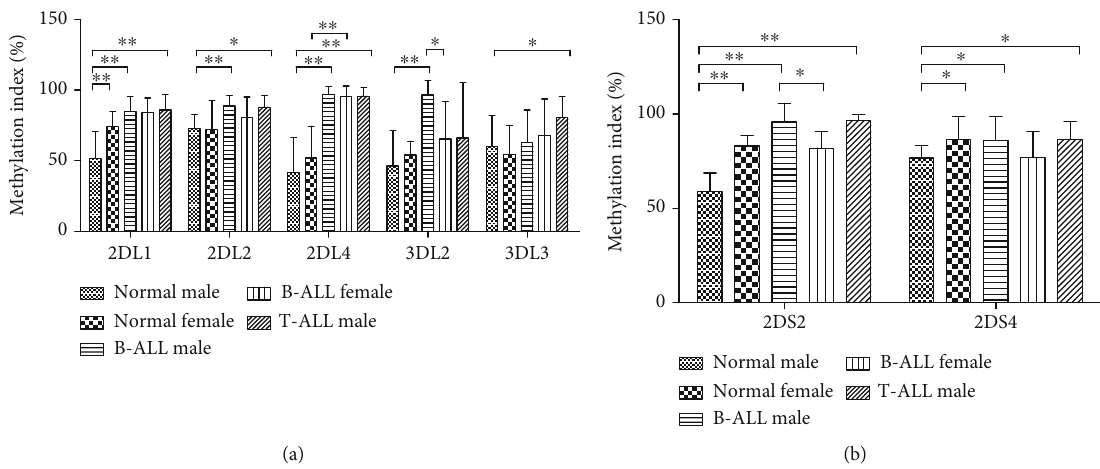
Figure 2: Methylation indexes in the promoter regions of (a) inhibitory KIR genes and (b) activating KIR genes in normal male controls ( n = 12 ), normal female controls ( n = 12 ), B-ALL male patients ( n = 12 ), B-ALL female patients ( n = 12 ), and T-ALL male patients ( n = 10 ). Data are presented as mean ± standard deviation . Mann-Whitney U test compared mean of two groups. “ ∗ ” indicates statistical signi fi cance p < 0 : 05 and “ ∗∗ ” indicates statistical signi fi cance p < 0 : 001 .